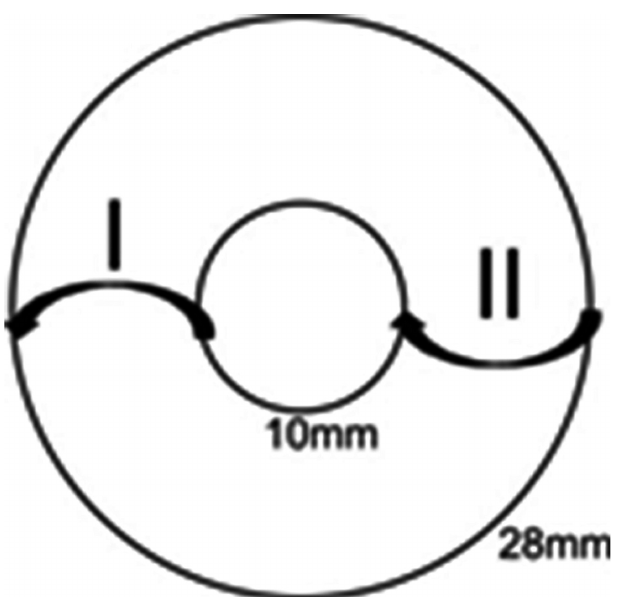
Fig. 3 - Mounting the pulsatile endoprosthesis with 5 stents connected in series in system of pulse generator, oscilloscope and current